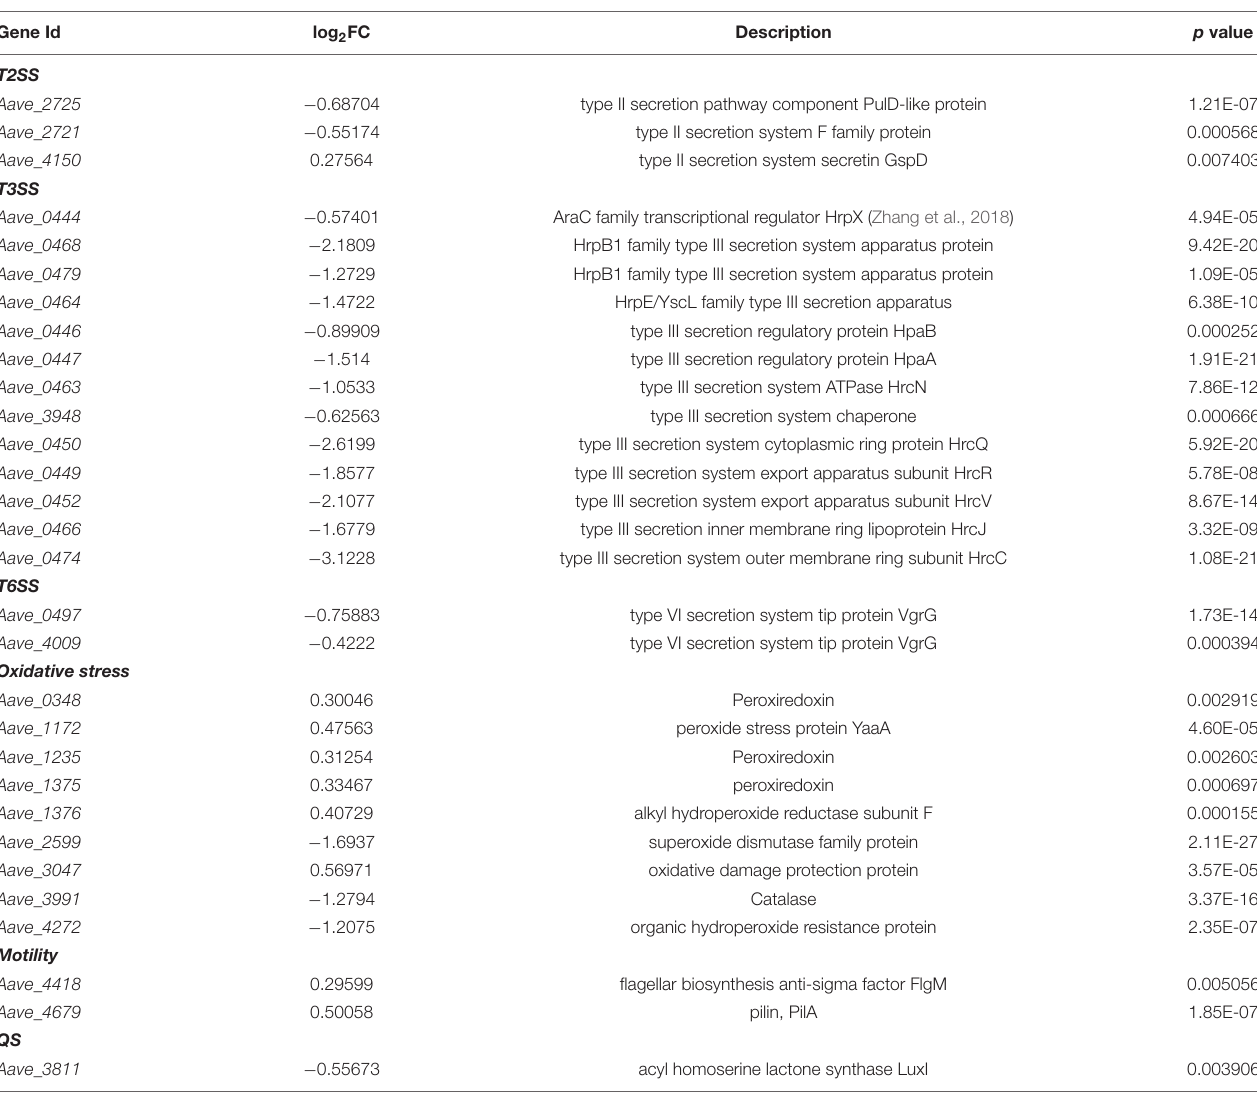
TABLE 1 | Differentially expressed genes related to Acidovorax citrulli